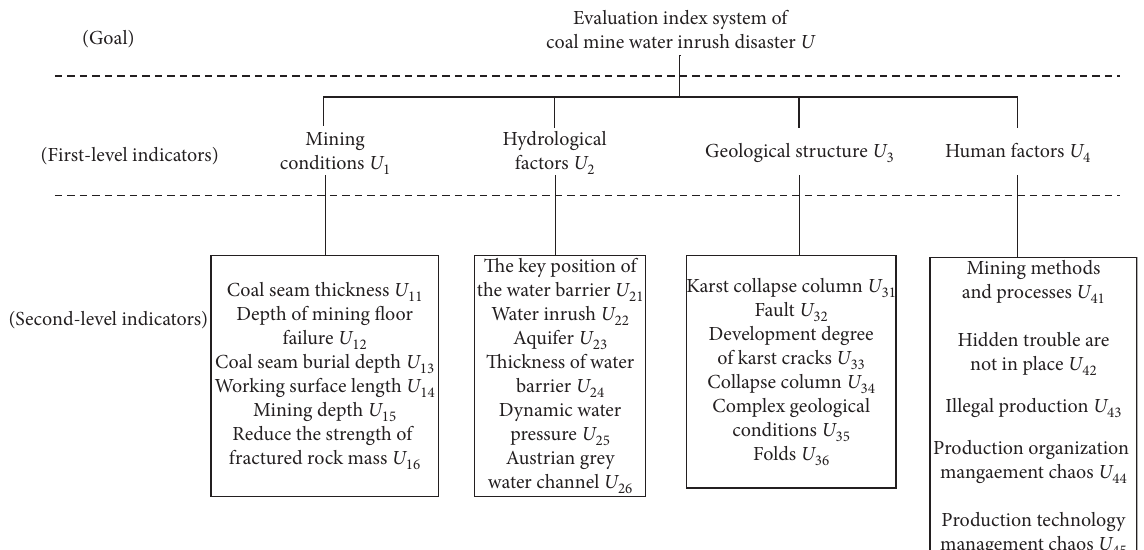
Figure 4: Network index system of the coal mine water inrush disaster.